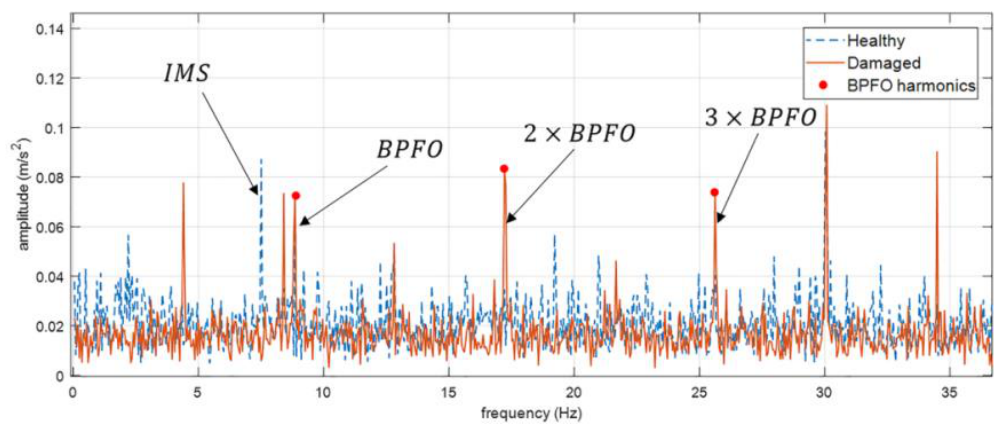
Figure 5. EESFO for the BPFO detection of the PLC upwind bearing damage corresponding to sensor AN5. EESFO represents the enhanced envelope spectrum by feature optimization, BPFO represents the ball pass frequency outer race, PLC represents planet carrier, and AN5 denotes a sensor.